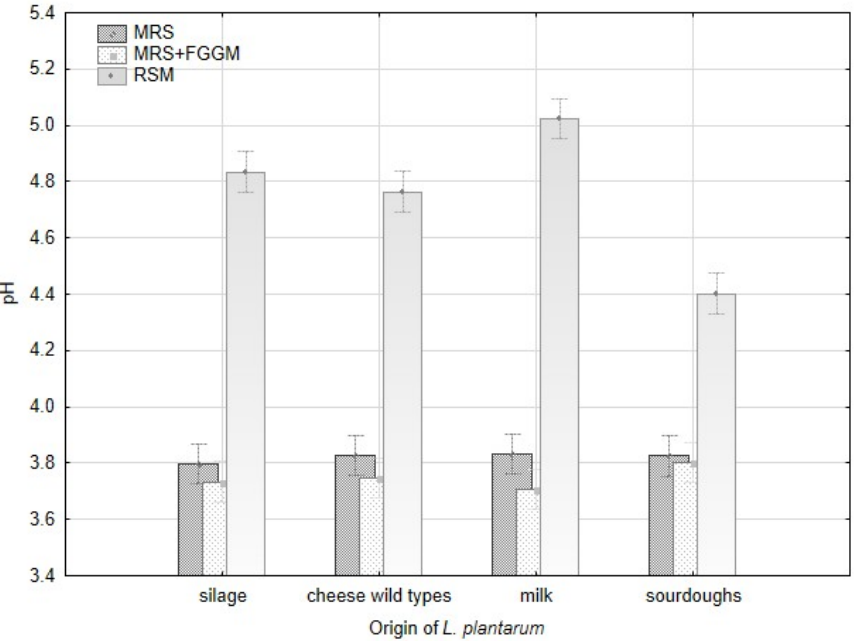
Figure A2. Variability in production of lactic acid by L. plantarum strains with respect to strain origin and three cultivation media- MRS, MRS + FGGM and reconstituted milk.